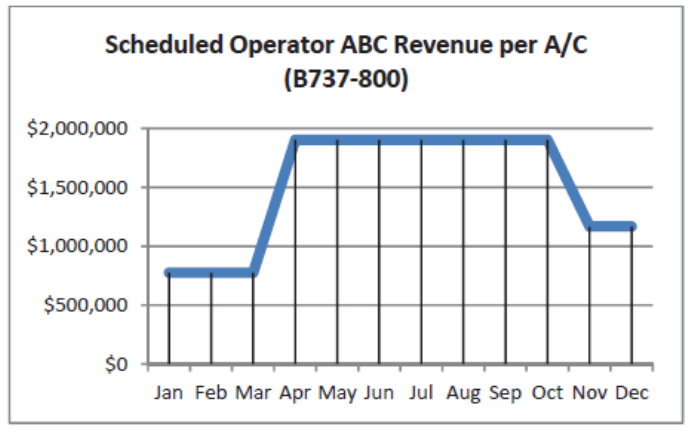
Figure 4: Scheduled Operator ABC Revenue per A/C; Source: (Saltoglu et. Al.,